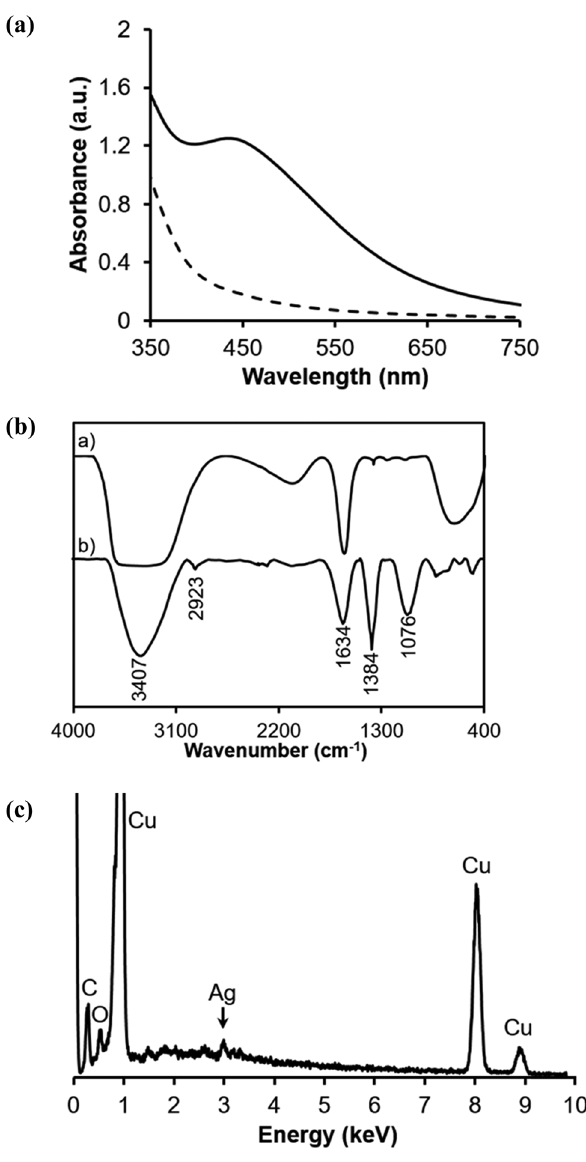
Figure 3: UV - vis spectra of the OT - ext ( dashed line ) and the OT - AgNPs ( solid line ) ( a ) ; the FT - IR spectra ( b ) and EDS analysis ( c ) of the OT -